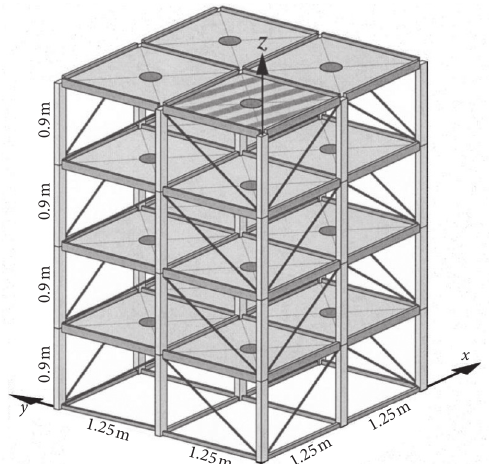
Figure 5: Diagram of IASC-ASCE benchmark structure